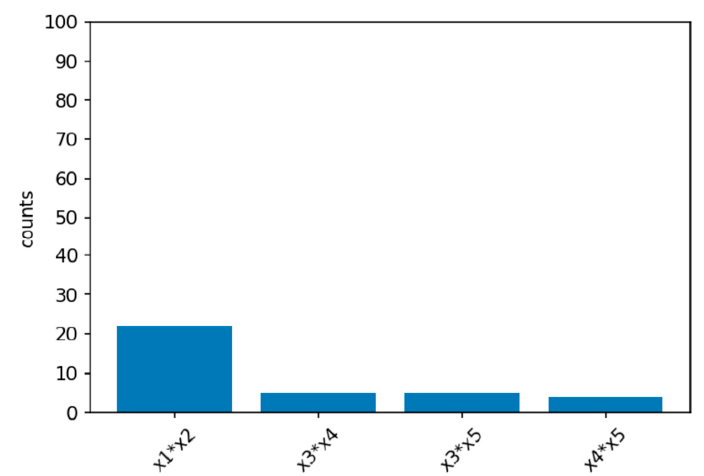
Figure 4. Power simulation under the mild interaction effect of normal (0.5, 1) for XGB-FI.